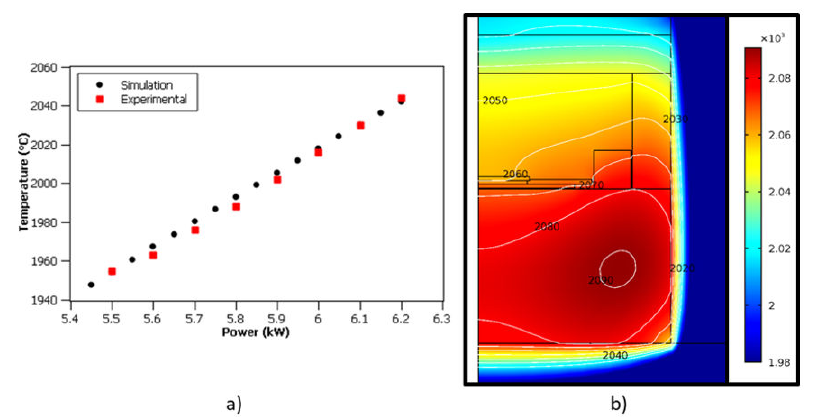
Figure 23. ( a ) Comparisons between simulations using COMSOL Multiphysics and the measured temperatures at the crucible top during growth runs for different heating powers in the 50 mm- CS-PVT setup. ( b ) Typical temperature field for CS-PVT. Some isotherms are indicated with the corresponding